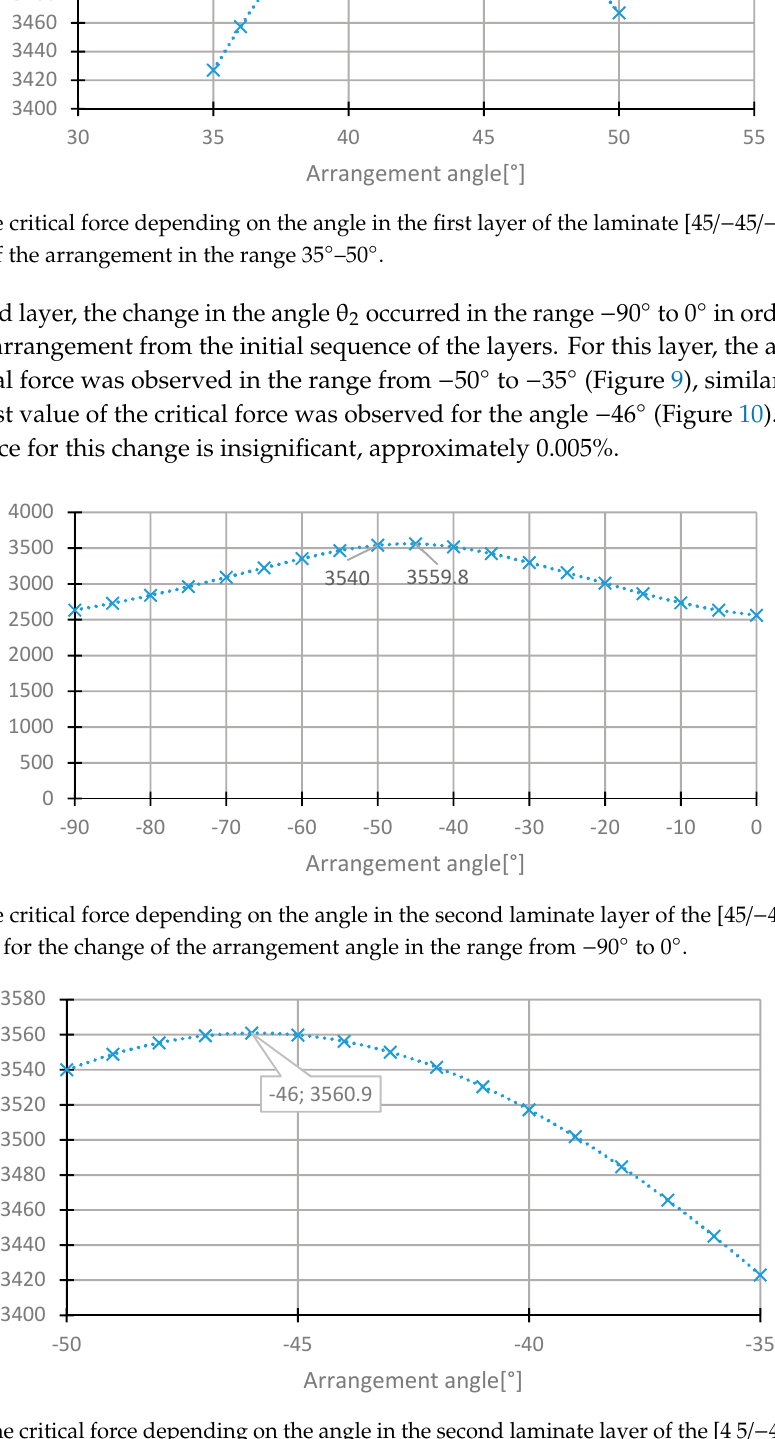
Figure 10. The critical force depending on the angle in the second laminate layer of the [4 5/ − 45/ − 45/45] arrangement for the change of the arrangement angle in the range from − 50° to 35°.